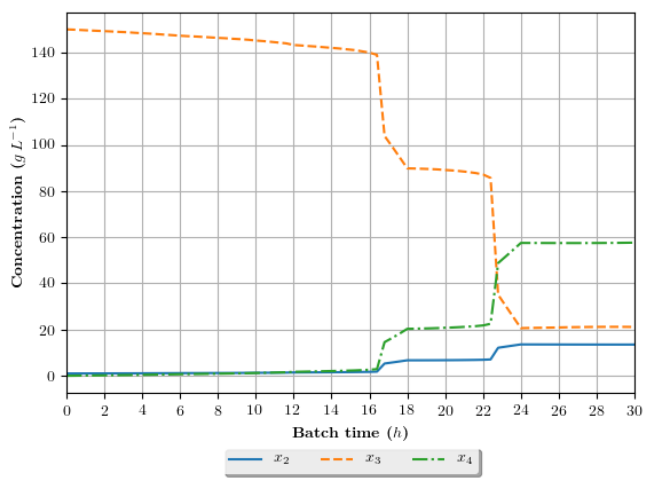
Figure 10. Growth profile for the assay of number 9 (6h/GA/cos—6h interval between DRTO cycles, GA as the optimization algorithm and coisinoidal feed rate parametrization), in terms of the concentration of cellular biomass ( x 2 ), substrate ( x 3 ) and ethanol ( x 4 ) during the batch.